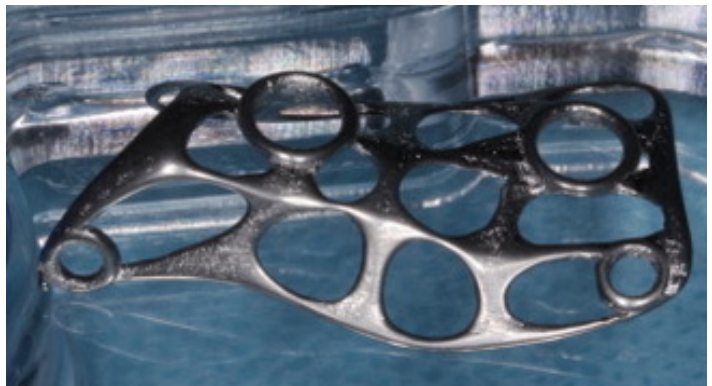
Figure 1. Ti6Al4V mesh used in this study.